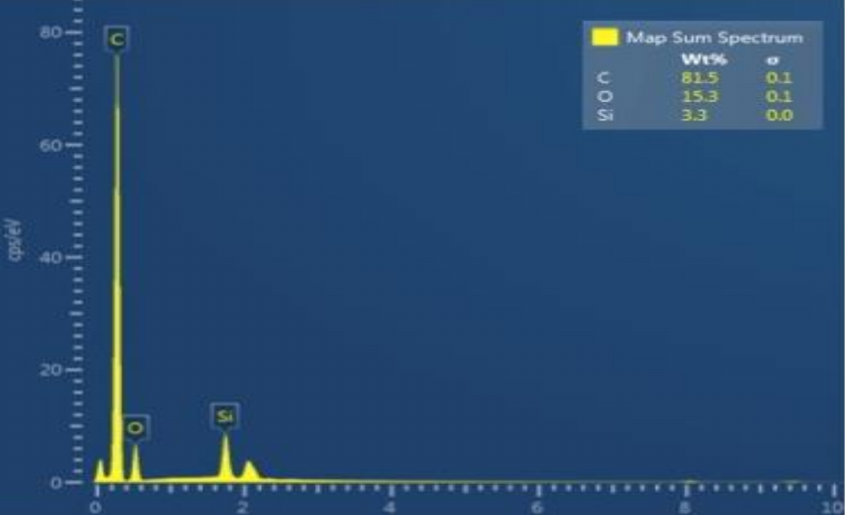
Figure 2. The EDX line analysis (rGO 5 wt%) adhesive showing evidence of high carbon percentage (81.5%) along with Si dispersion in the experimental